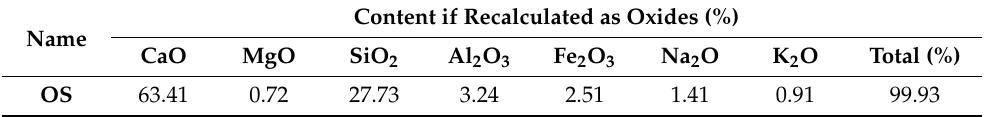
Table 1. Chemical composition of the